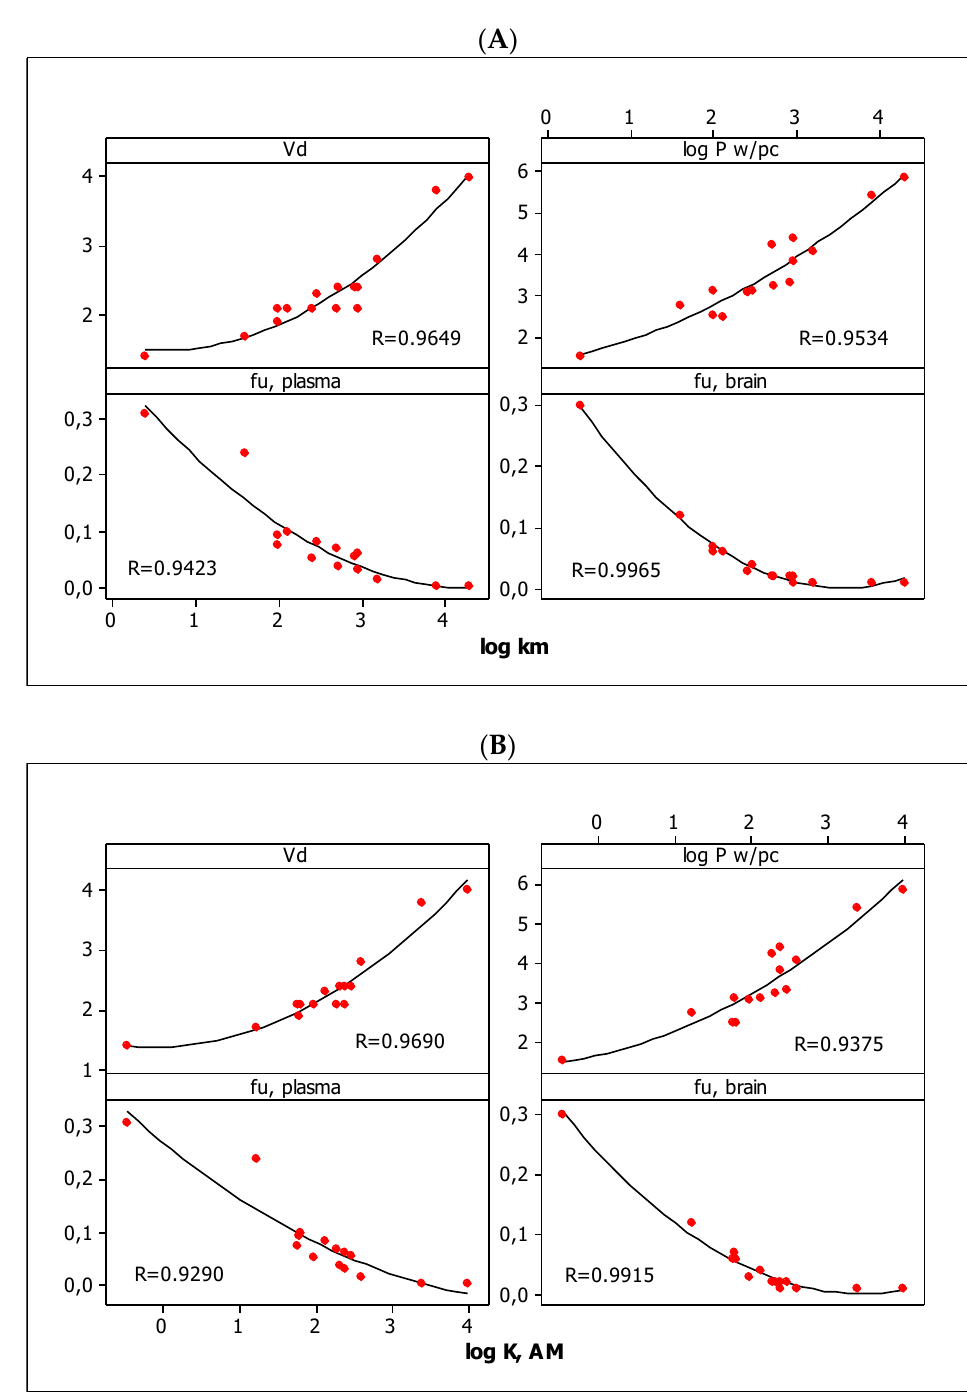
Figure 3. The parabolic relationships between pharmacokinetic parameters and log k m ( A ) and log K AM ( B ) values.